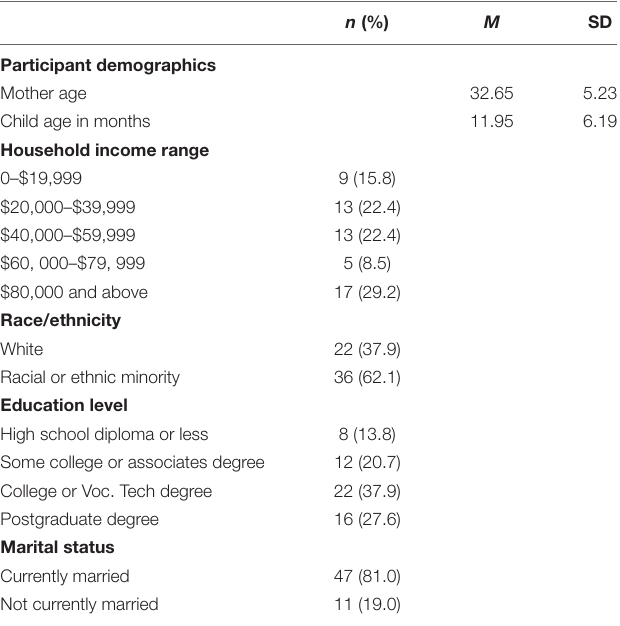
TABLE 1 | Frequencies (and percentages) for social demographic characteristics ( N = 58) at baseline assessment.